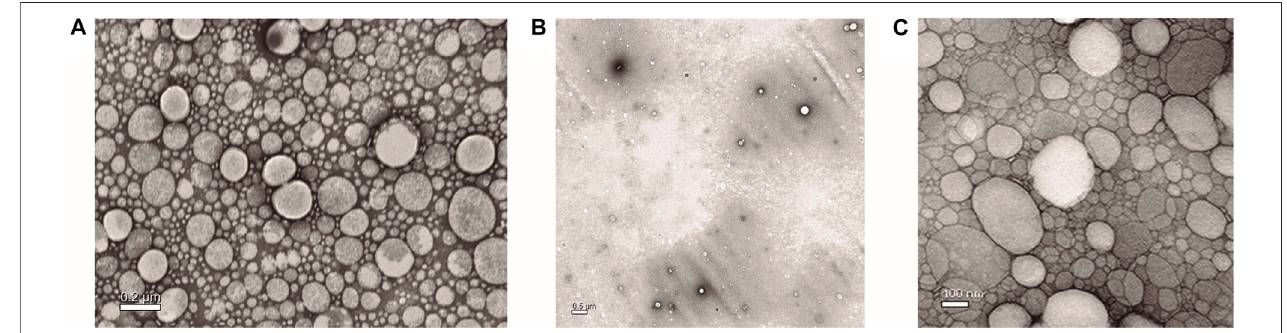
FIGURE 4 | Stacked DSC thermograms corresponding to PB, myristyl myristate, Poloxamer 188, NLC-vehicle, and NLC-PB. Note: Y -axis scale is the same for all thermograms.